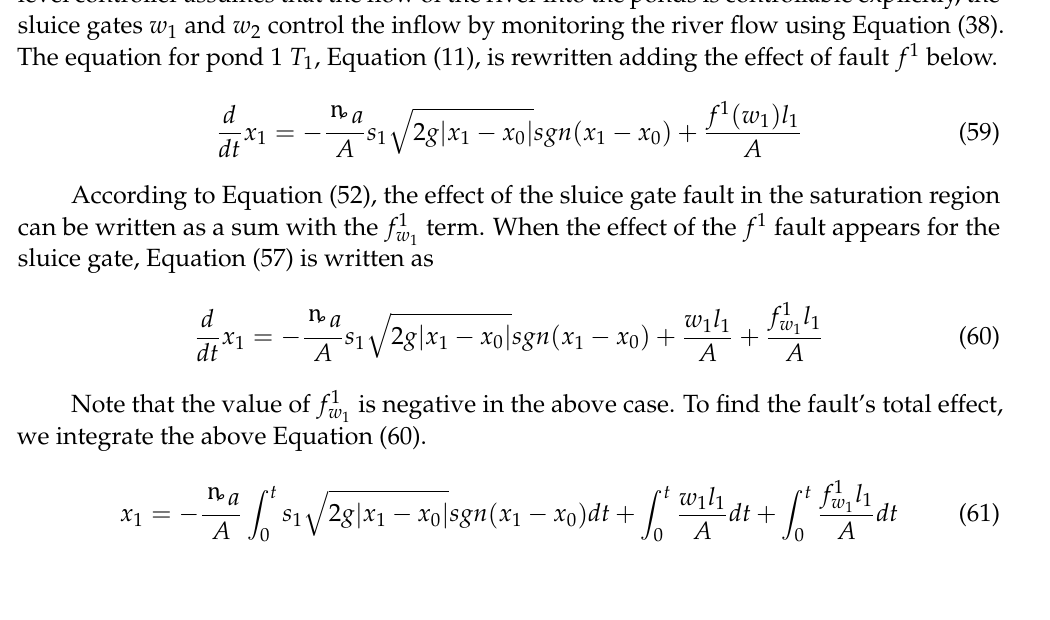
Figure 1. Three-pond hydraulic system.